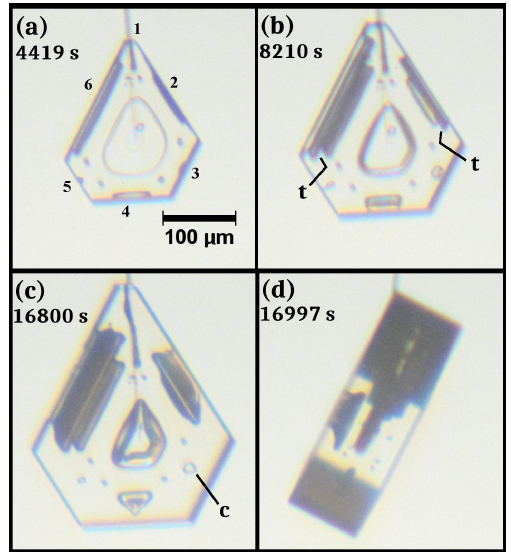
Figure 11. Center hollow development and center pocket formation. The crystal is the same as that in Fig. 7, but at later times under the same conditions. The scale in (a) applies to all images. Numbers in (a) label the six prism faces; t in (b) marks terraces; c in (c) marks a center pocket. Image (d) is a side